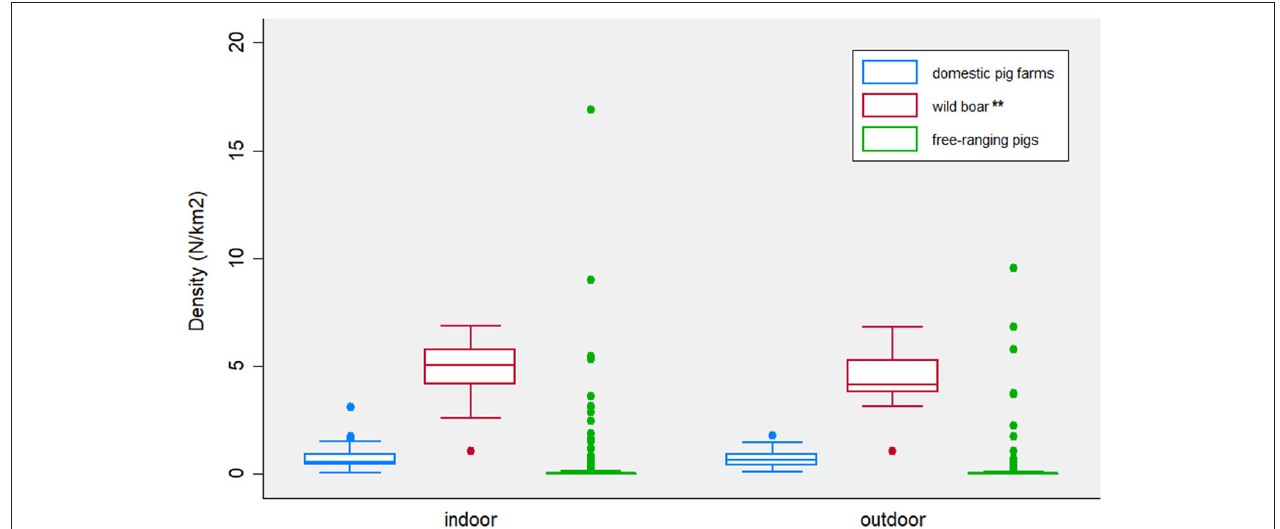
FIGURE 3 | Distribution of the density of domestic pig farms, wild boar and free-ranging pigs, expressed as number/km 2 , by indoor and outdoor farms. Features were collected based on 10 km 2 radius around each epidemiological unit (i.e., outbreak farm). Statistically significant differences between indoor and outdoor farms are identified by a p -value < 0.0001 (***), or p -value between 0.05–0.0001